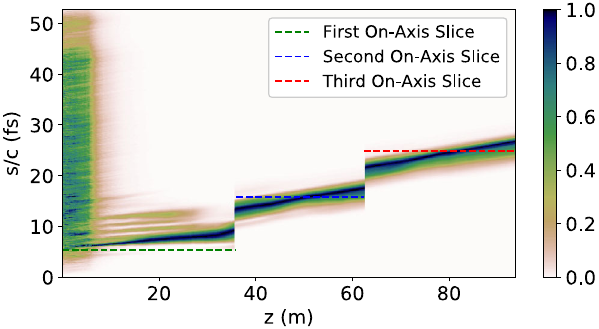
˜ P ð s Þ ¼ FIG. 8. The normalized XFEL power distribution P ð s Þ = max P ð s Þ along the bunch at different z in the undulator s beam line. The green, blue, and red dashed lines show the locations of on-axis slices in the first, second, and third undulator sections,